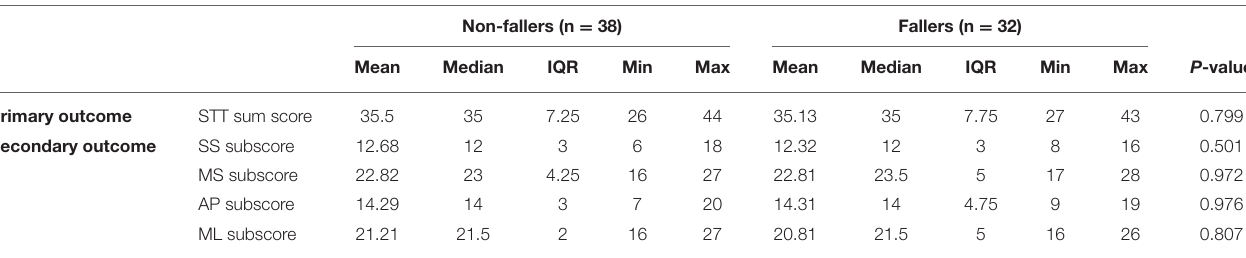
TABLE 6 | Differences between non-fallers and fallers in the STT sum scores (DSE).